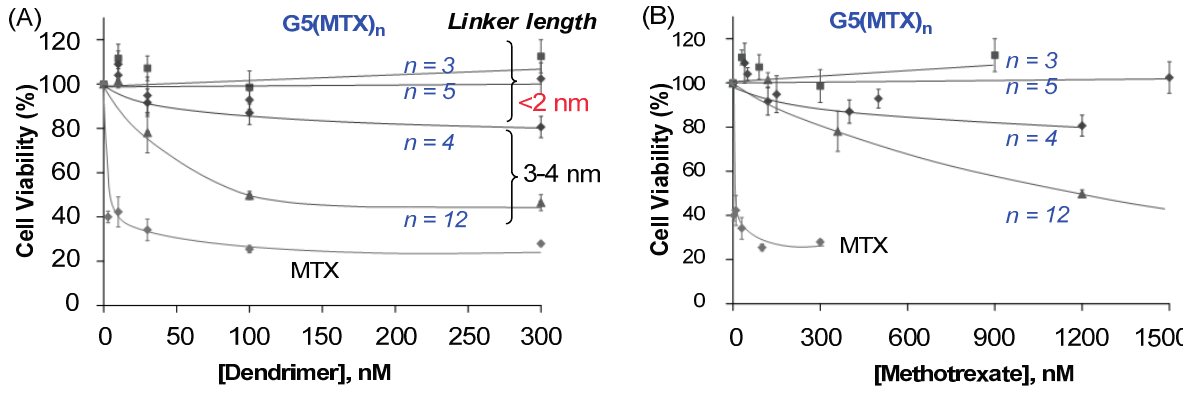
Figure 6. In vitro cytotoxicity of G5(MTX) n in FAR(+) KB cells determined by an XTT assay [78]. Each data point represents a mean value (±SD). Doses for each conjugate on the X -axis are expressed as either dendrimer ( A ) or MTX ( B )